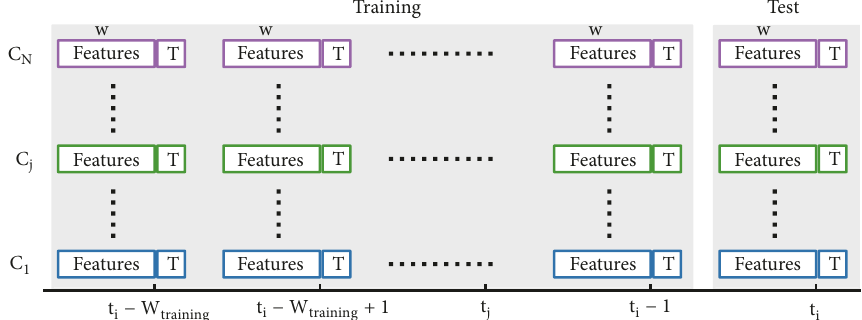
Figure 3: Schematic description of Method 1. The training set is composed of features and target (T) pairs, where features are various characteristics of a currency 𝑐 𝑖 , computed across the 𝑤 days preceding time 𝑡 𝑗 and the target 𝑇 is the price of 𝑐 𝑖 at 𝑡 𝑗 . The features-target pairs are computed for all currencies 𝑐 𝑖 and all values of 𝑡 𝑗 included between 𝑡 𝑖 − 𝑊 𝑡𝑟𝑎𝑖𝑛𝑖𝑛𝑔 and 𝑡 𝑖 − 1 . The test set includes features-target pairs for all currencies with trading volume larger than 10 5 USD at 𝑡 𝑖 , where the target is the price at time 𝑡 𝑖 and features are computed in the 𝑤 days preceding 𝑡 𝑖